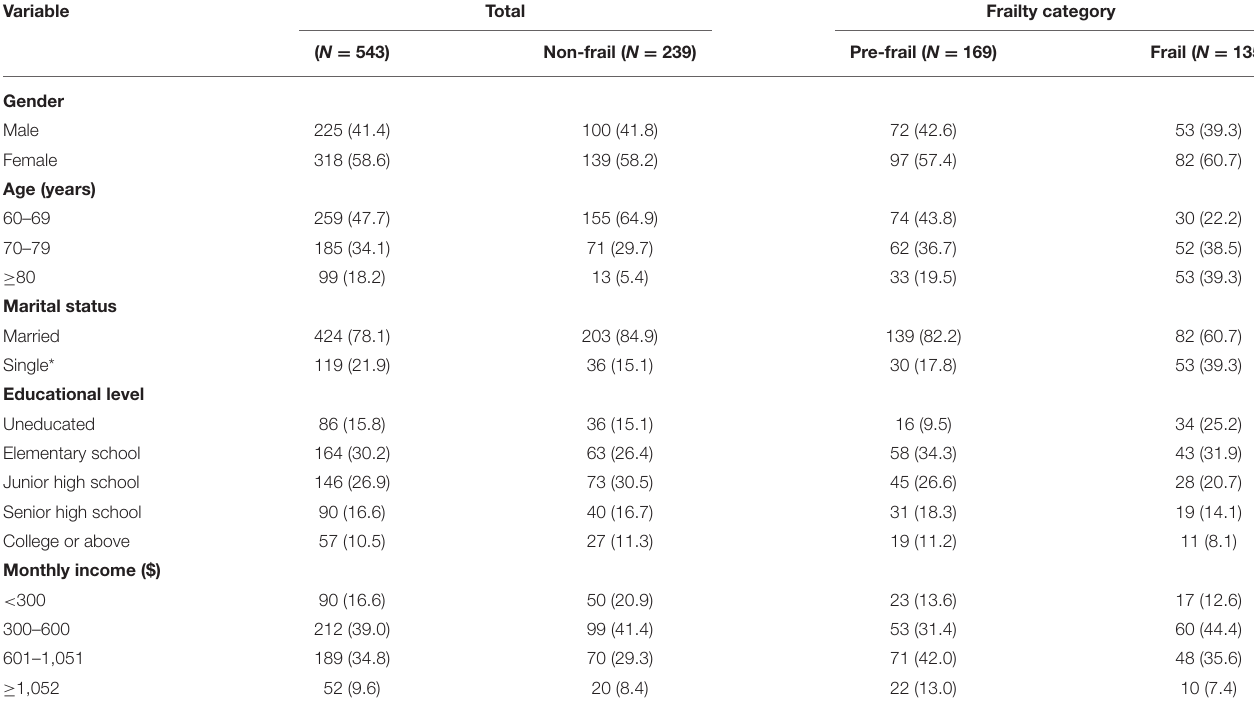
TABLE 1 | Demographic characteristics of community-dwelling older adults.